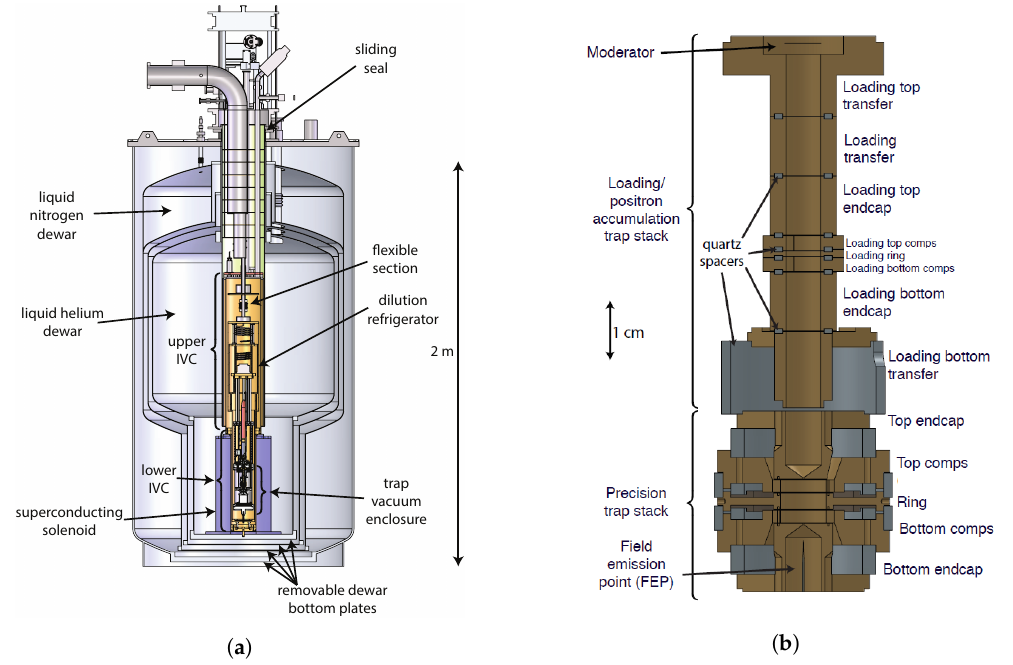
Figure 7. The cryogenic apparatus. ( a ) overview of the apparatus, showing the trap vacuum enclosure, solenoid, cryogen spaces and dilution refrigerator; ( b ) representation of the trap electrodes for positron loading and for precision measurements, each with an identifying